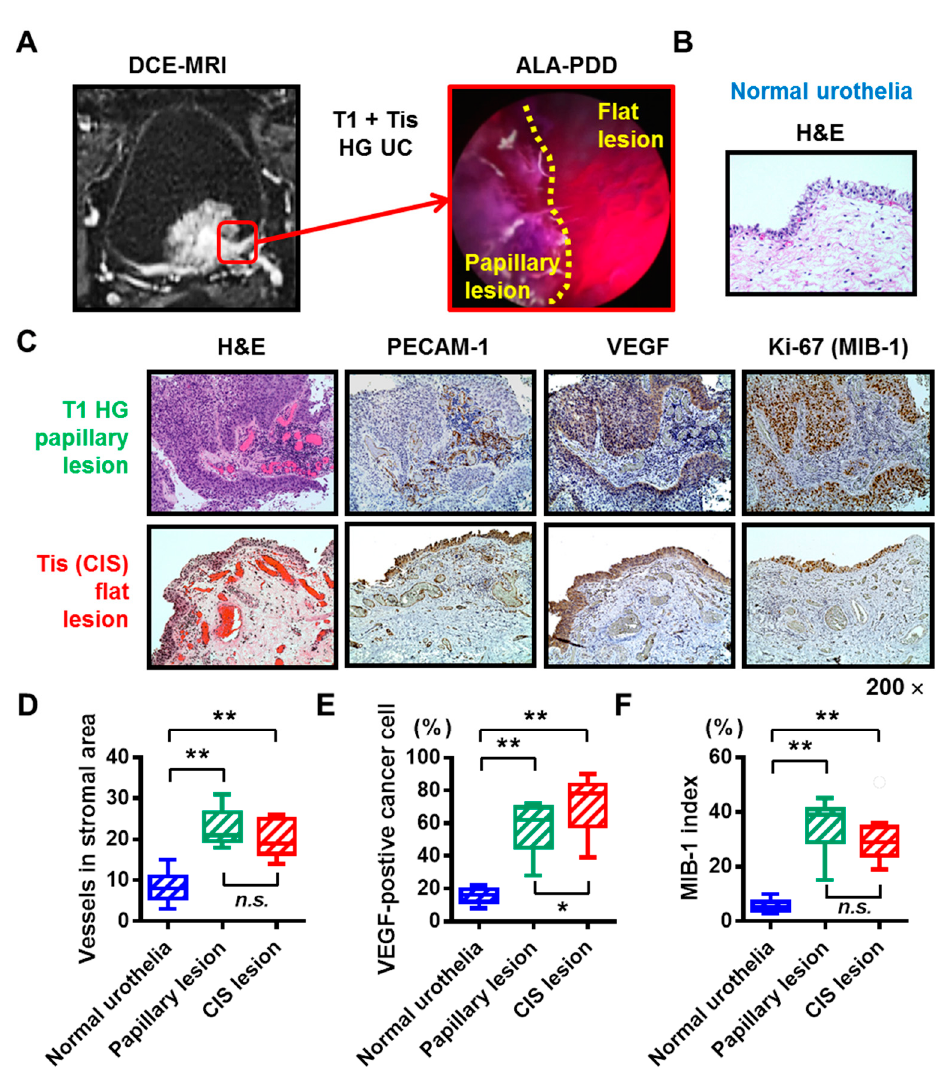
Figure 3. Hypervascularity and hyperproliferation of the bladder carcinoma in situ (CIS). ( A ) DCE-MRI imaging and ALA-PDD picture during TURBT of a representative case (the 73-year-old man). The red square indicates the border between the papillary tumor lesion (T1 high-grade urothelial carcinoma) and the flat tumor lesion (CIS). ( B ) H&E staining of the normal urothelia of the representative case. ( C ) All the images were captured at 200 × magnification. ( D – F ) The matching specimens of the normal urothelial, papillary tumor lesion, and CIS from the nine patients with papillary tumor and concomitant CIS were compared with IHC analysis for PECAM-1, VEGF, and Ki-67. The number of stromal vessels, percentage of VEGF-positive cancer cells, and the percentage of proliferating cancer cells were quantified and compared. In the box-and-whisker plot or bar charts, significance (* p < 0.05, ** p < 0.01) was assessed by the paired Wilcoxon signed-rank test. CIS, carcinoma in situ; DCE, dynamic contrast enhanced; MRI, magnetic resonance imaging; ALA, 5-aminolevulinic acid; PDD, photodynamic diagnosis; TURBT, transurethral resection of the bladder tumor; n.s. , not